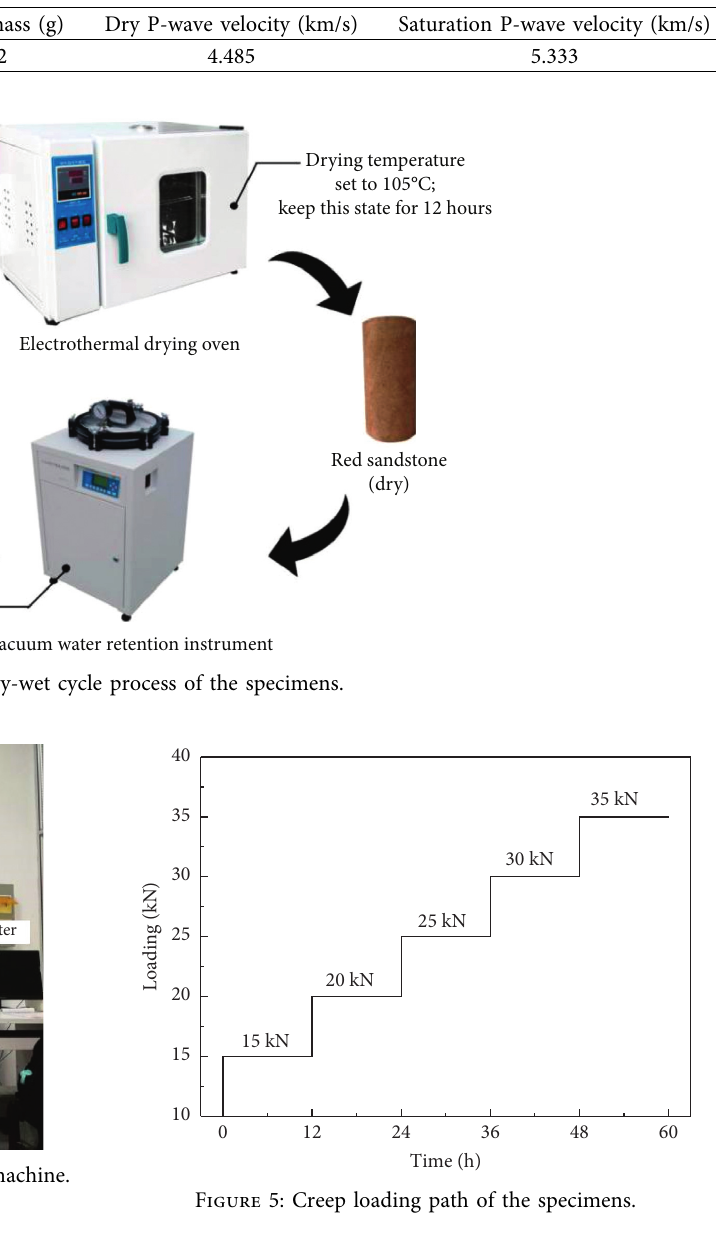
Table 1: The average value of the basic physical parameters of the red